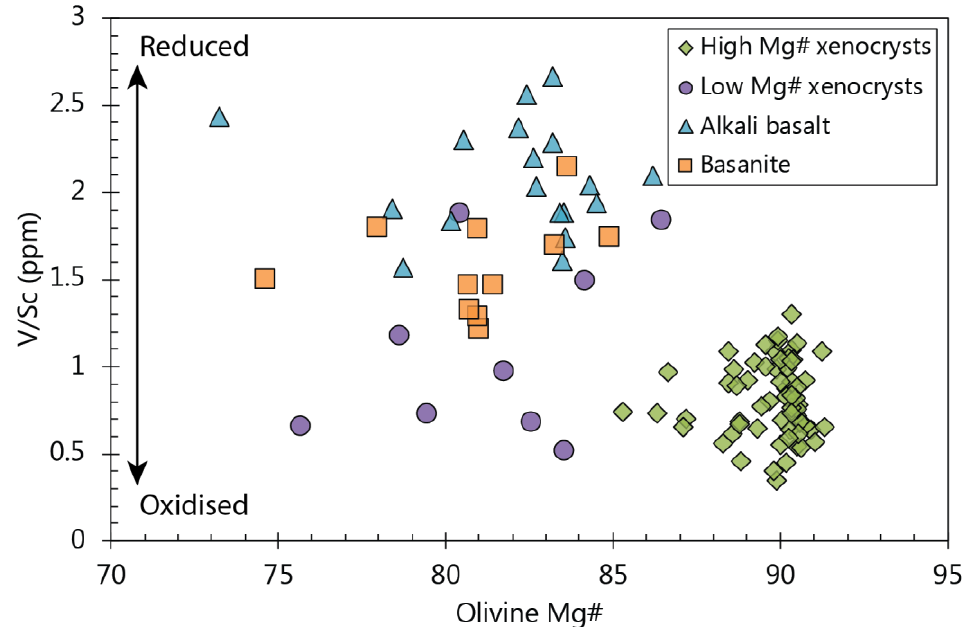
Figure 6. V / Sc plotted against Mg# of Buckland olivine phenocrysts and xenocrysts. Low V / Sc indicates an oxidised environment, while high values indicate a reduced environment. However, this may be interfered with by minerals such as amphibole and phlogopite in the source assemblages.